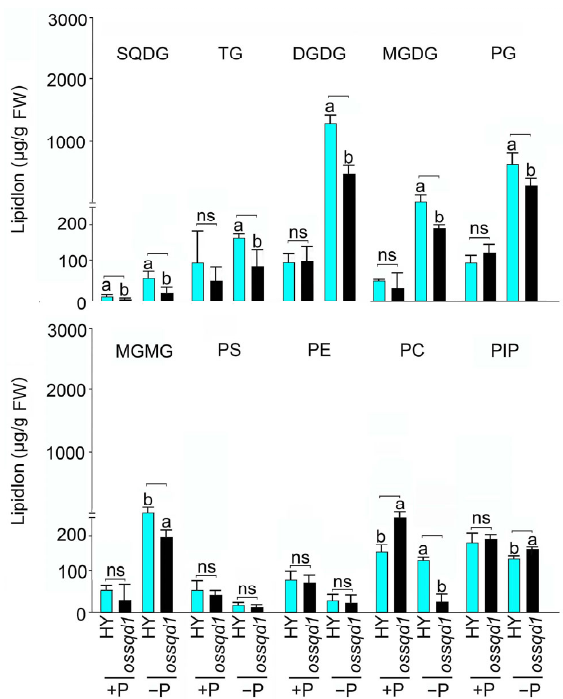
Figure 2. OsSQD1 altered concentration of different lipid species in roots under different Pi regimes. The concentrations of different species of lipids in WT and ossqd1 mutant roots under +P and − P conditions. SQDG, sulfoquinovosyldiacylglycerol; TG, triglyceride; DGDG, digalactosyldiacylglycerol; MGDG, monogalactosyldiacylglycerol; PG, phosphatidylglycerol; MGMG: monogalactosylmonoacylglycerol; PS, phosphatidylserine; PE, phosphatidylethanolamine; PC, phosphatidylcholine; PIP: phosphatidylinositol-4-monophosphate. Lipidlon replaces the concentration of lipid molecule. Values are means ± SE ( n = 4) and different letters on the histograms indicate that the values differ significantly between WT and ossqd1 mutant. ( p < 0.05, one-way analysis of variance, Duncan’s test). ns = not